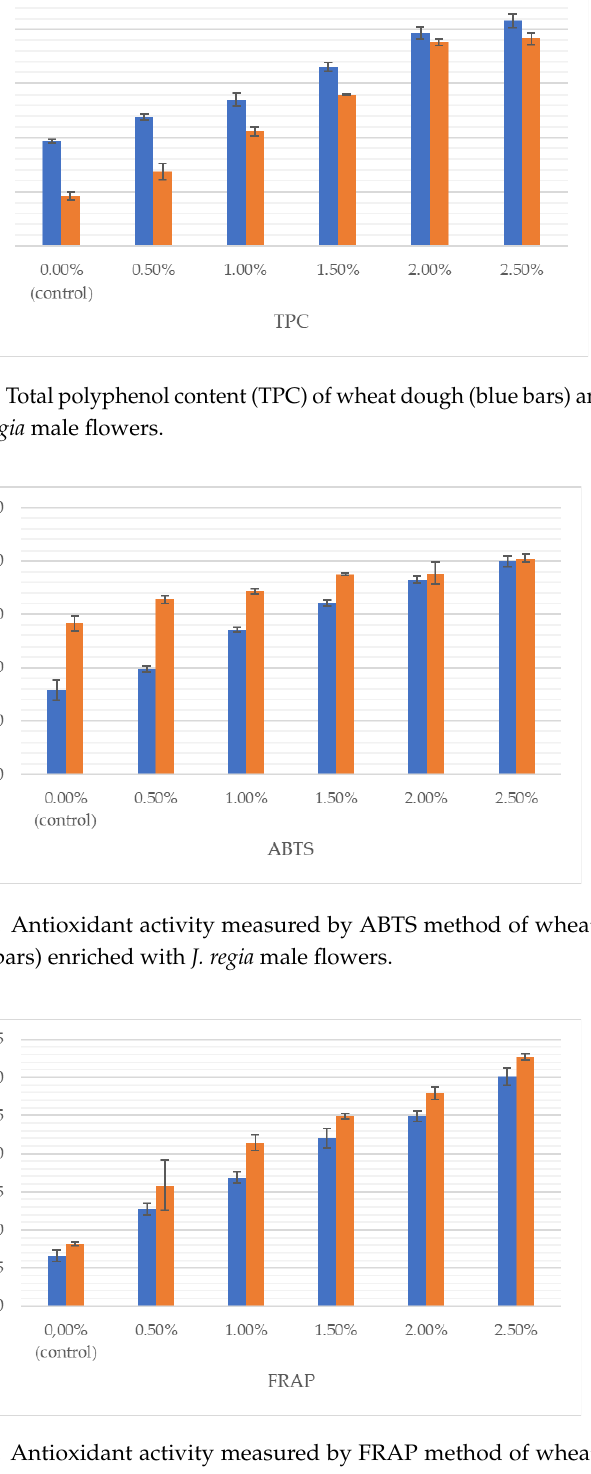
Figure 4. Antioxidant activity measured by FRAP method of wheat dough (blue bars) and bread (orange bars) enriched with J. regia male flowers.